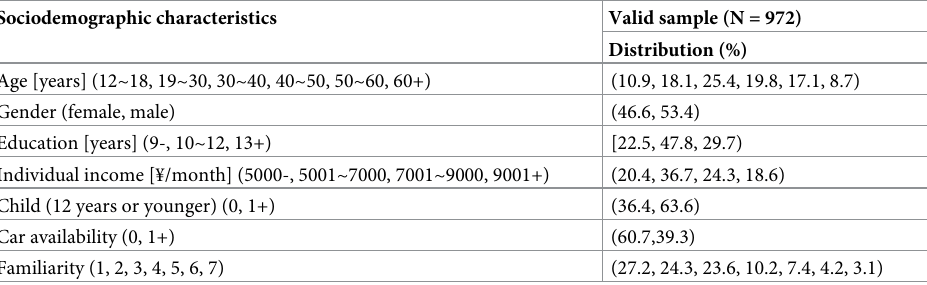
Table 1. Descriptive statistics: Sociodemographic characteristics of respondents. Sociodemographic